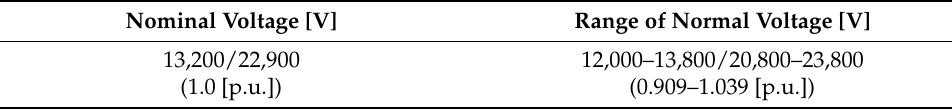
Table 1. Operating voltage of the distribution system in KEPCO.